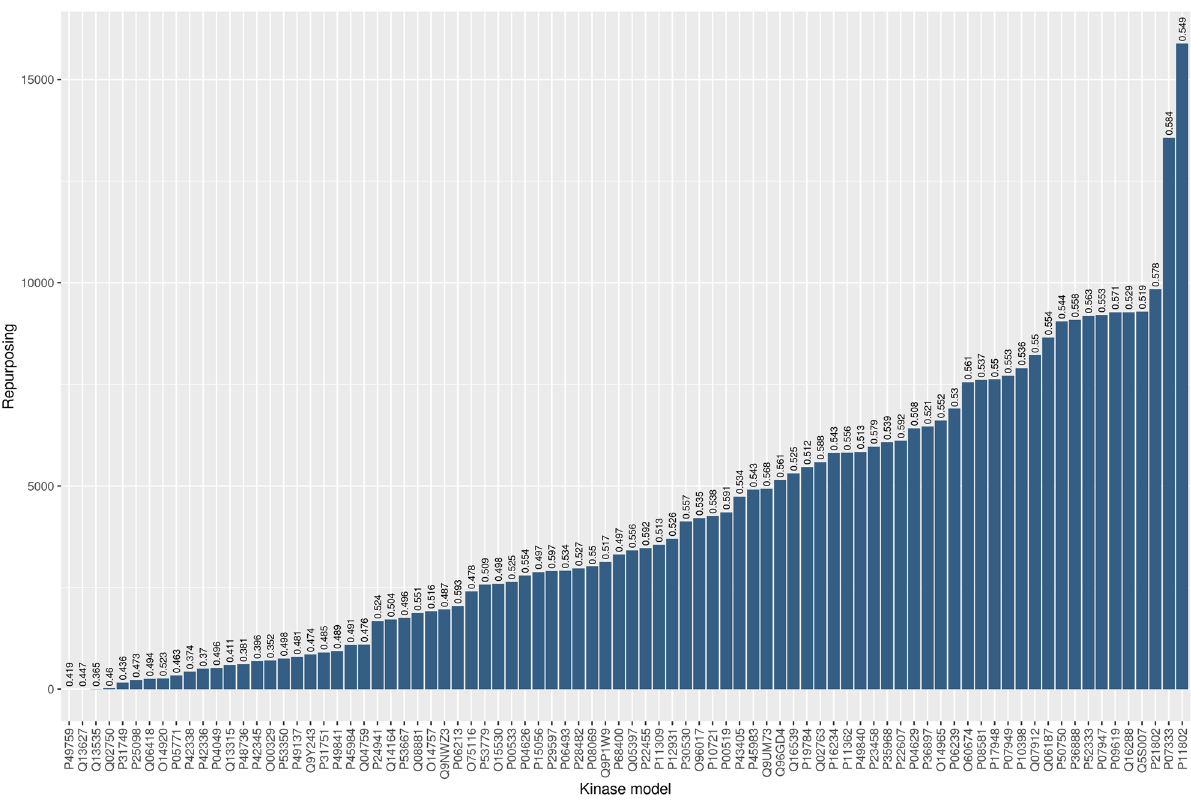
Figure 6. Predicted actives distribution related to 84 UKs models. In the X-axis the BMF1-related kinases are reported, while in Y-axis the number of repurposable ligands which achieved an MTPS score higher than repurposing threshold (RT) is reported in ascending order. On top of each bar the average MTPS score for each predicted protein–ligand pair is